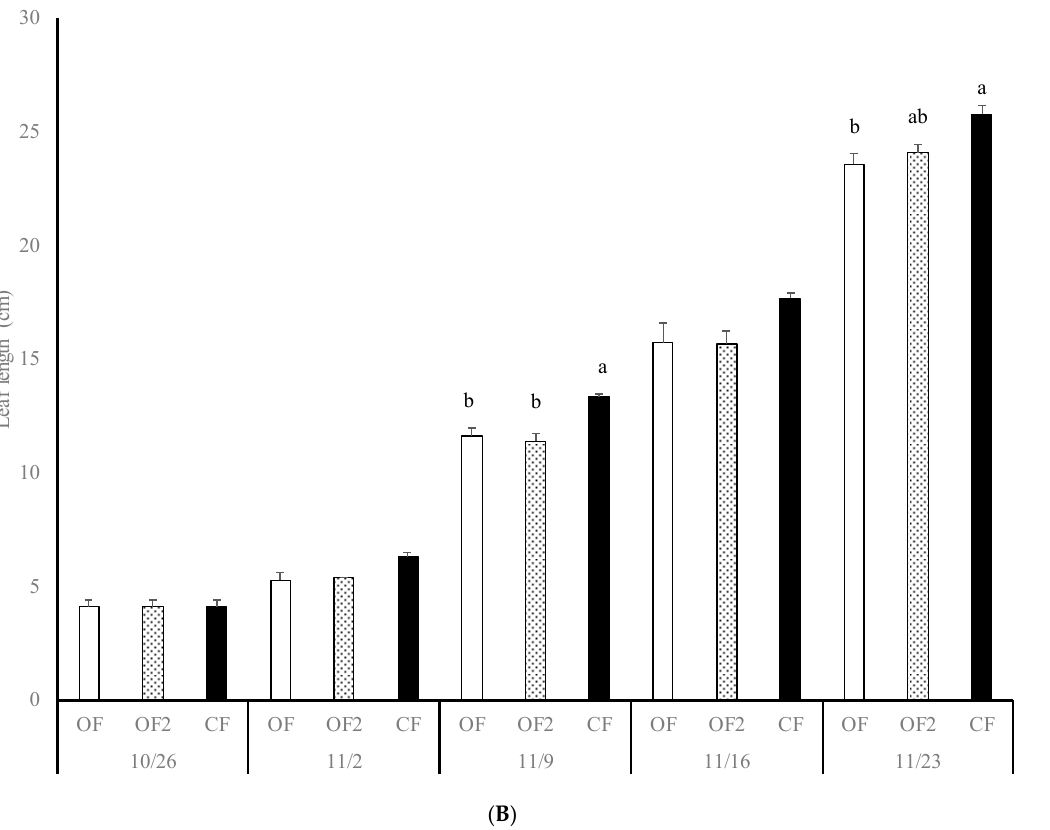
Figure 2. Changes in bok choy leaf length under the different fertilization methods. ( A ): Summer, ( B ): Autumn. Error bars on vertical columns indicate standard error ( n = 3). Identical letters under the same date indicate no significant difference ( p < 0.05) between treatments according to Tukey’s multiple range test. Bok choy in CF was harvested on 10 August because the mean leaf length exceeded 20 cm ( A ). * indicates a significant difference ( p < 0.05) between the other two treatments according to the Student’s t -test. OF (organic fertilizer): corn steep liquor (CSL) applied as organic fertilizer at the same amount of total nitrogen as that in the half unit of Otsuka A formula; OF2: CSL applied at twice the amount of total nitrogen in OF; CF (chemical fertilizer): half unit of Otsuka A formula.